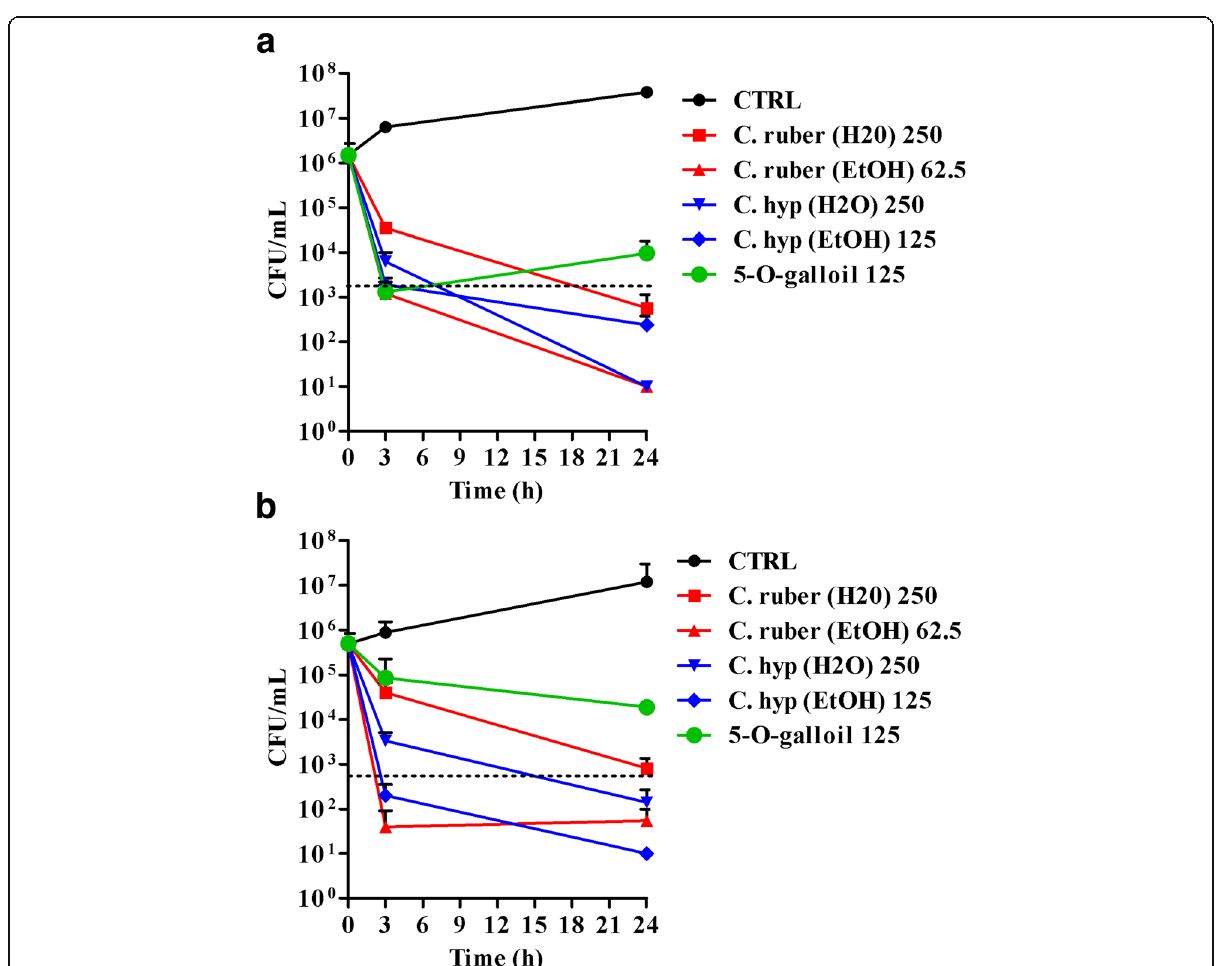
Fig. 3 Killing kinetics of Cytinus hypocystis and Cytinus ruber extracts (at concentrations ranging from 62.5 to 250 μ g/ml) and penta-O-galloyl- β -D- glucose (abbreviated as 5-O-galloyl in the graphs, 125 μ g/ml) against S. aureus ATCC 33591 ( a ) and S. epidermidis ATCC 35984 ( b ). Bacteria were incubated in sodium-phosphate buffer 10 mM, pH 7.4 supplemented with 2% LB in the presence of the antimicrobial compounds for 3 and 24 h. Control (CTRL) represents untreated bacteria. Dashed line represent 3 Logs reduction in CFU count as compared to inoculums. The numbers in the figure legend are the concentrations used expressed in μ g/ml. Data are expressed as mean ± standard error of at least